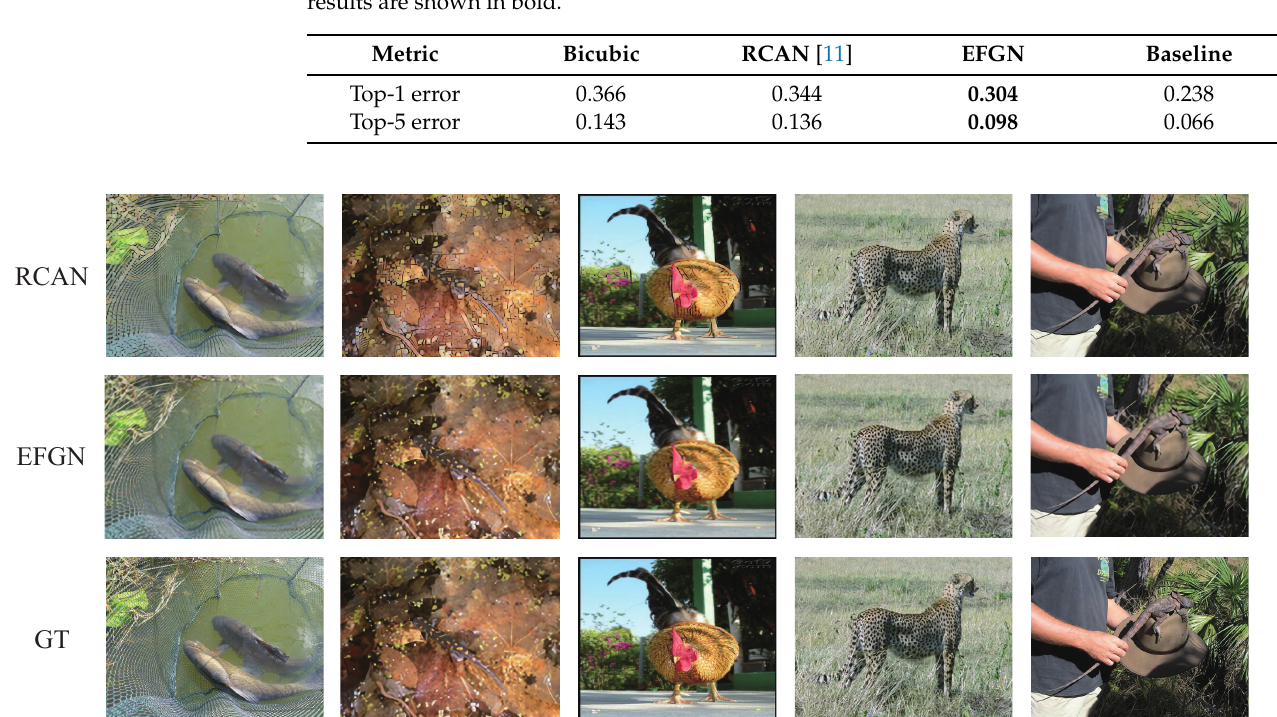
Figure 11. Visual comparison of RCAN with our proposed EFGN at × 4 super-resolution on images from